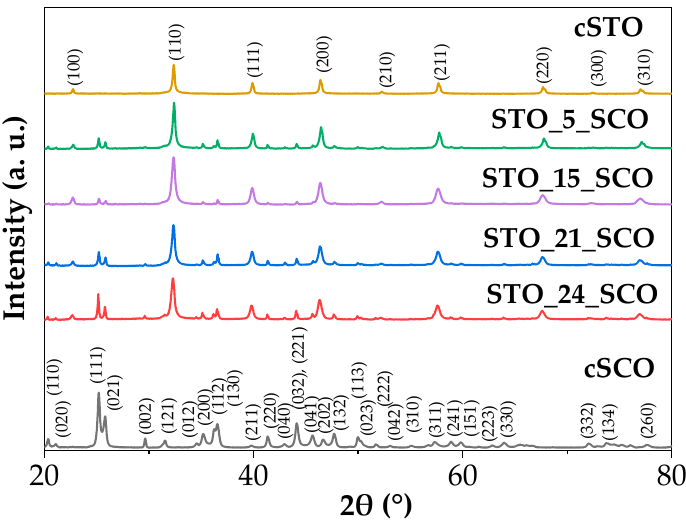
Table 1. Summary of the applied strategy aiming for the control of SrCO 3 content and the primary crystallite size (PCS) of components for all tested photocatalysts (STO_x_SCO, x = 5, 15, 21, and 24 wt%).